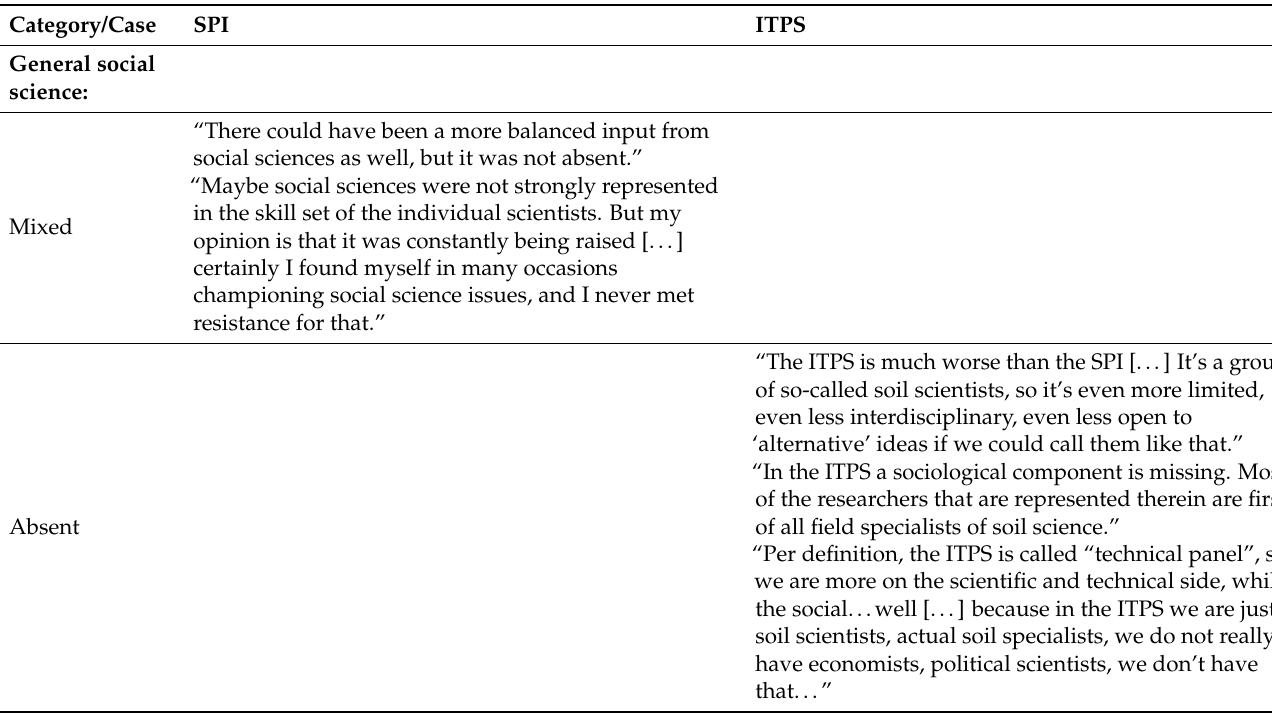
Table 2. Comparison of the two cases across selected